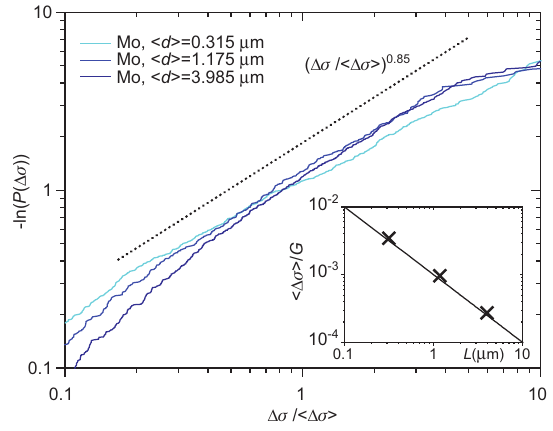
Figure 4 Size dependence of the flow stress and flow stress varia- tion of [100]-oriented Mo single crystals (both parameters deter- mined at 15%